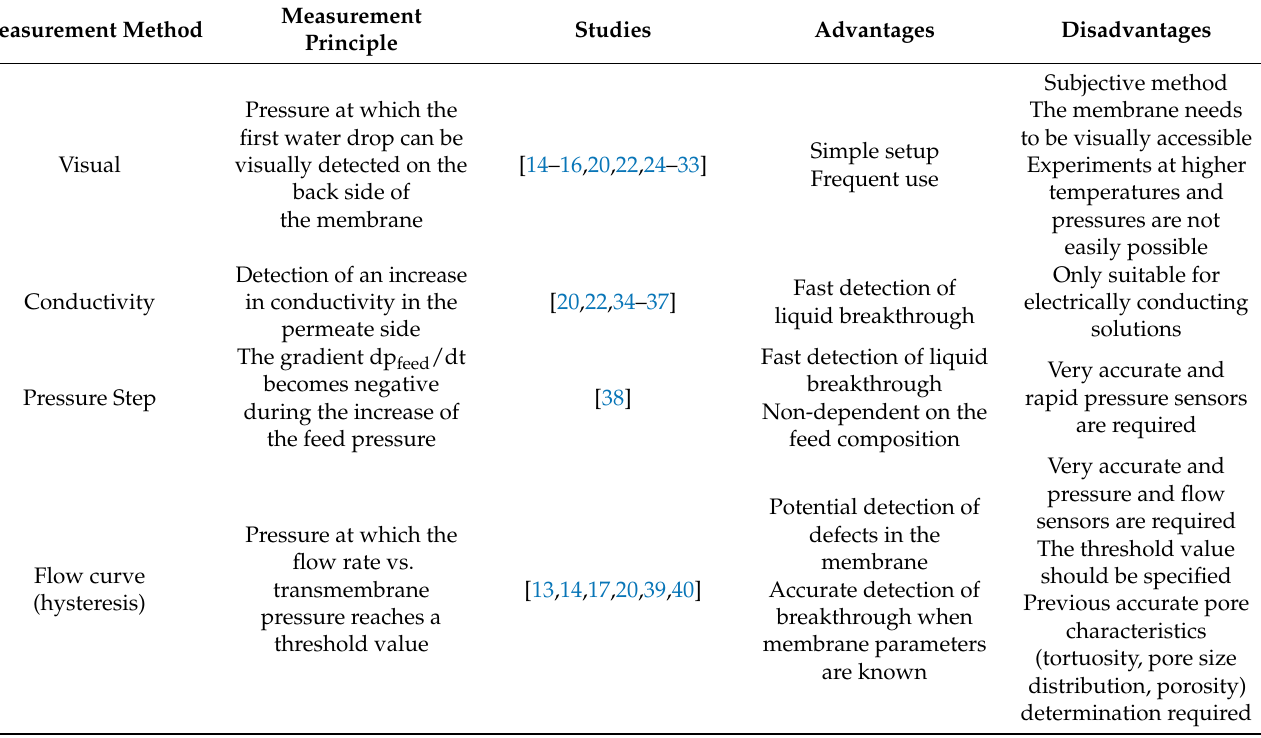
Table 1. Overview of experimental methods to determine the Liquid Entry Pressure in the literature. Measurement